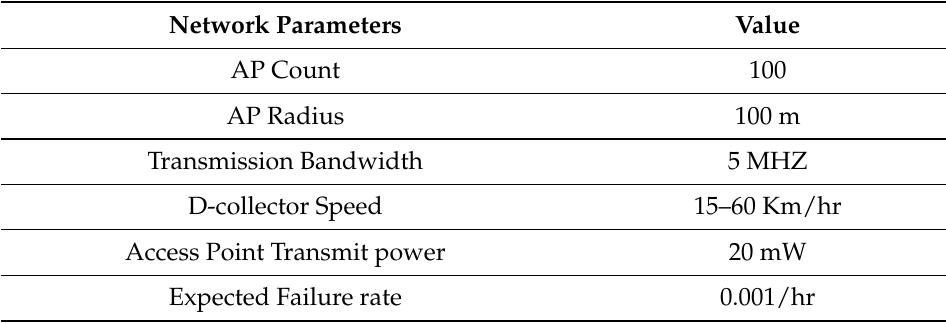
Table 1. Network